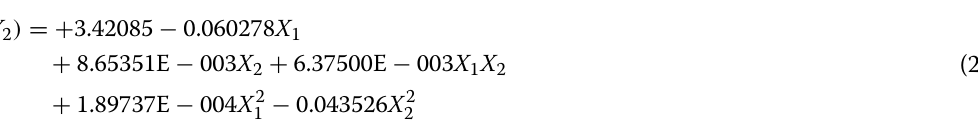
pH of phosphate buffer ( X 2 ) exhibited a positive effect, but the combination of both the independent variables exhibited a positive effect on the tailing factor ( Y 2 ).